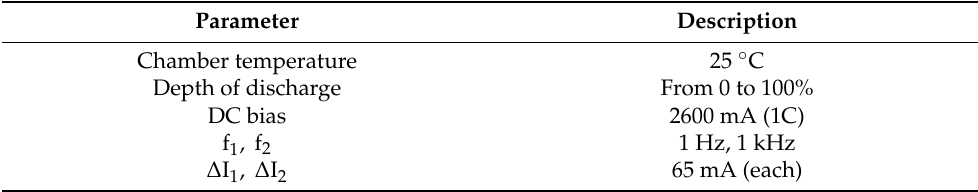
Table 2. Experimental conditions for measuring cell impedance during discharge.